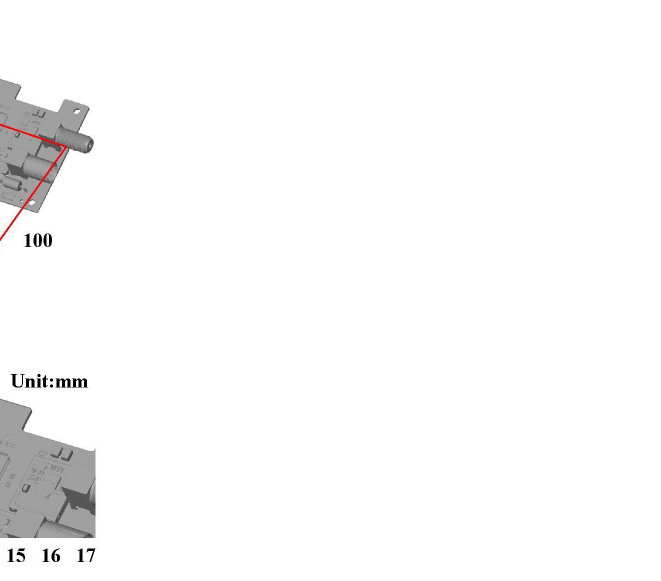
Figure 16. Measurement results of the circuit board that was sprayed with a mixture of TiO 2 powder and ethanol before optical measurements. Materials 2022 , 15 , 6139